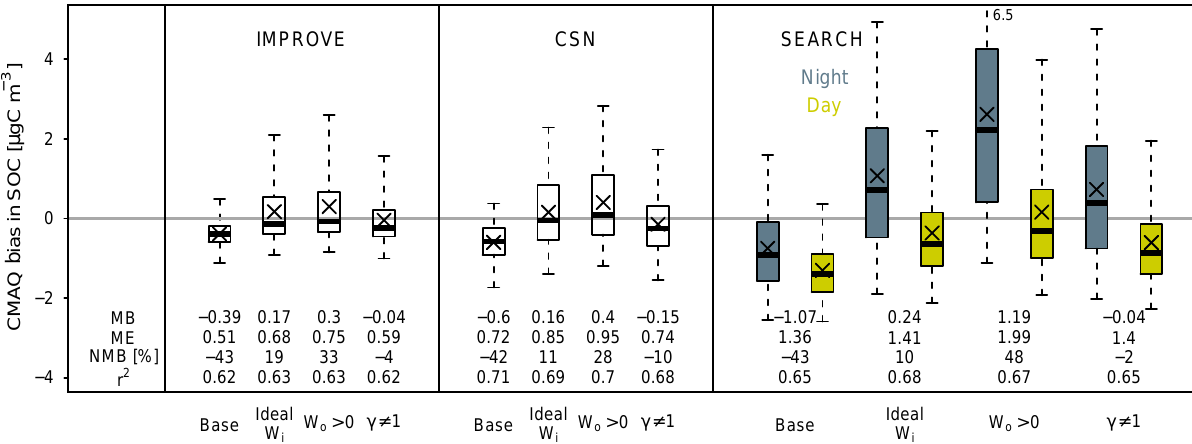
Figure 9. Bias (model–observation) in SOC for IMPROVE, CSN, and SEARCH networks. SEARCH data are divided into daytime (06:00 to 19:59LT) and nighttime observations. SOC is calculated using OC / EC ratios and estimating evaporation of semivolatiles as described in Sect. 2.9. X symbols indicate mean bias. Boxplots indicate 5th, 25th, median, 75th, and 95th percentile. r 2 based on a zero intercept.